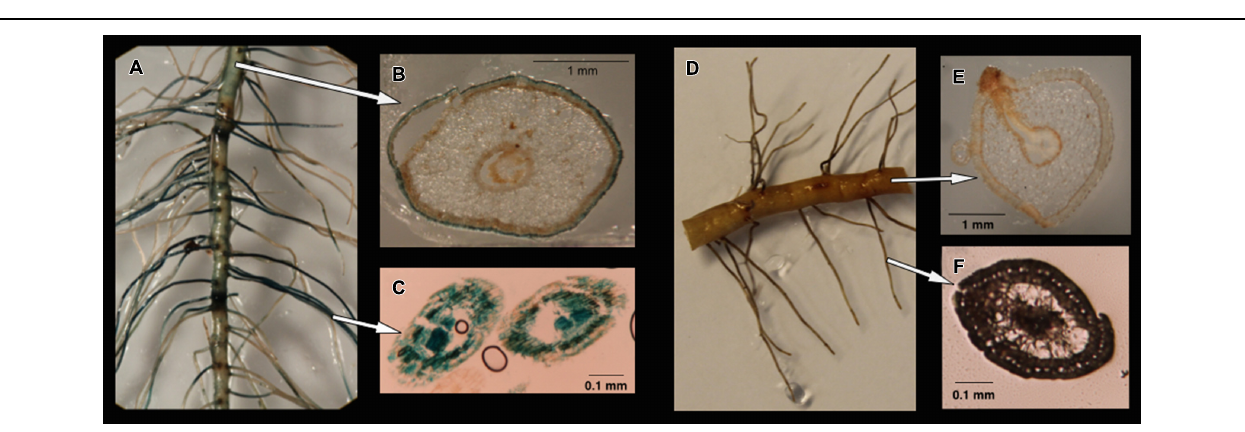
(B) M. mangrovicola Gal22 transformant carrying the nifH::gusA fusion. gusA expression is under the control of the nifH promoter, and can only be visualized with a blue color formation under N 2 -fixing conditions in nitrogen-free medium.